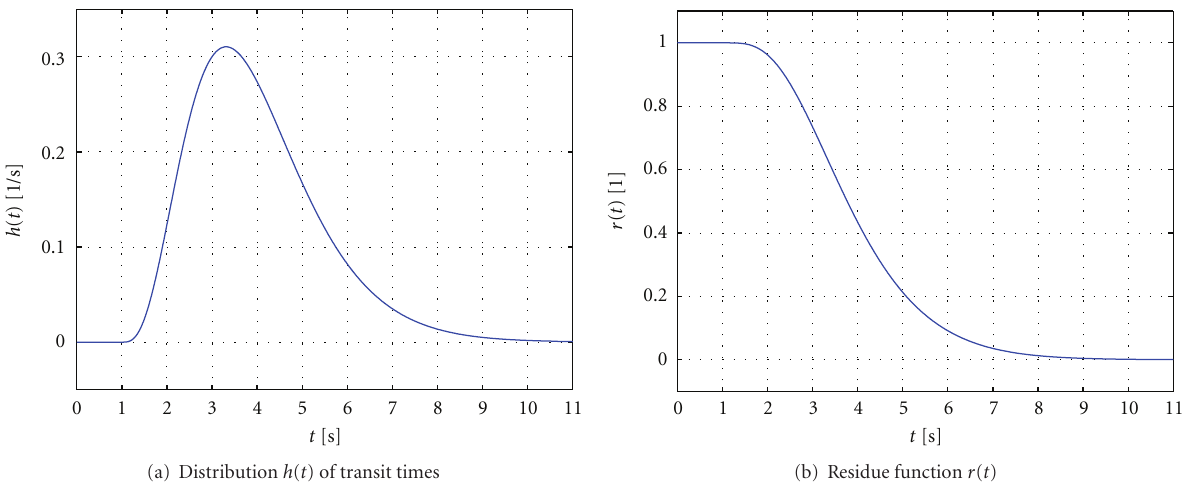
Figure 4: Examples of the distribution function h ( t ) of transit times (the mean transit time is 4 s) and the corresponding residue function r ( t ). Table 1: Summary of parameters used to derive the indicator-dilution theory and to define clinically relevant tissue perfusion quantities.